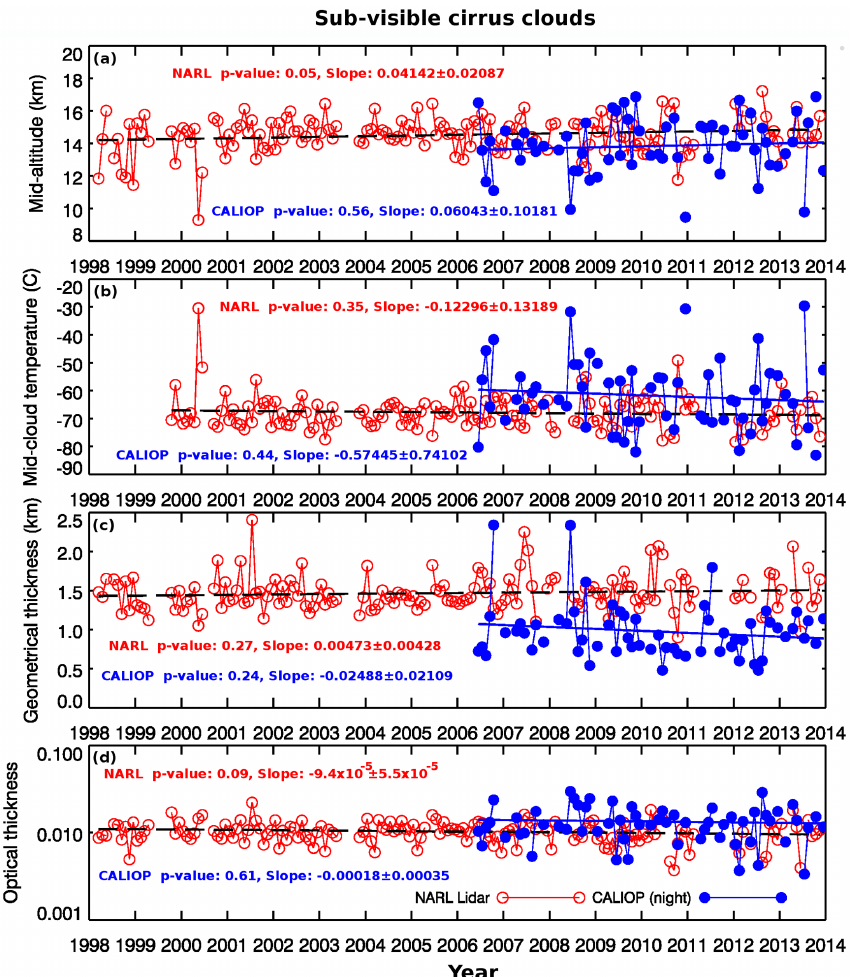
Figure 11. Time series of monthly mean (a) mid-cloud altitude, (b) mid-cloud temperature, (c) geometrical thickness and (d) optical thickness of sub-visible cirrus clouds obtained using NARL Lidar (shown by open red circles) and CALIOP night time data (shown by blue filled circle). The dashed black line shows the linear fit to the NARL Lidar data points while the solid blue line shows the same for CALIOP data points. Slopes are expressed in unit per